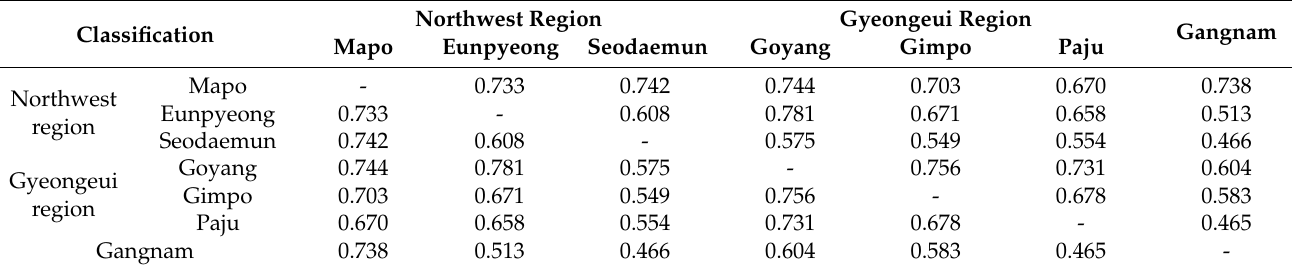
Table 10. Correlation analysis of sales price between individual cities.